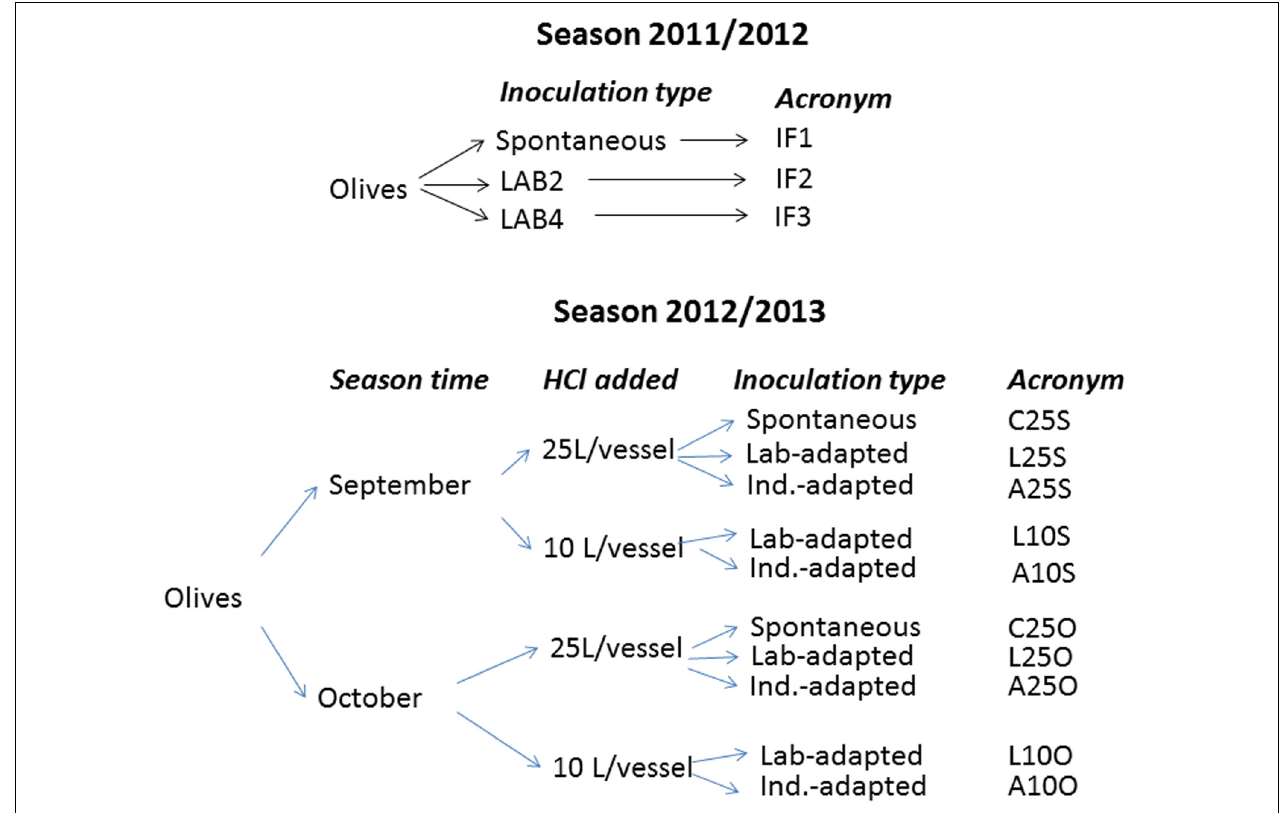
FIGURE 1 | Flow chart of the experimental design according to the season. All experiments were performed in duplicate (independent fermentation vessels), and the HCl always was food grade quality (35%, w/w). The correspondence between variable levels and symbols are: September, S; October, O; 25 or 10 L HCl added in initial brine /vessel, 25 and 10, respectively; Spontaneous fermentation, C; culture pre-adapted at the laboratory or industrial scales, L and A,